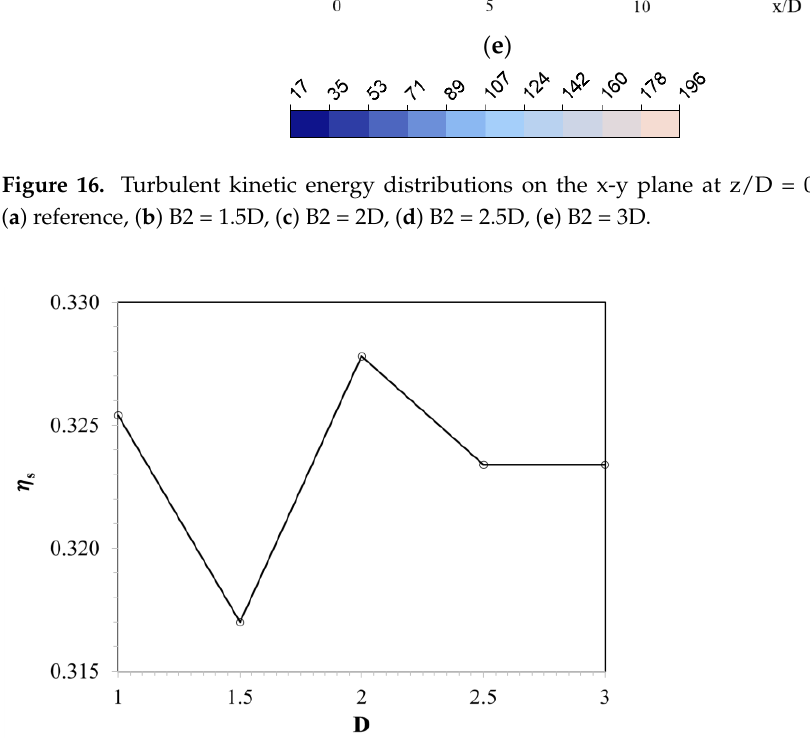
( d ) ( e ) Figure 18. Velocity vectors on x-z plane at y/D = 0 [Unit: m/s]: ( a ) reference, ( b ) F2 = 1.5D, ( c ) F2 = 2D, ( d ) F2 = 2.5D, ( e ) F2 = 3D.